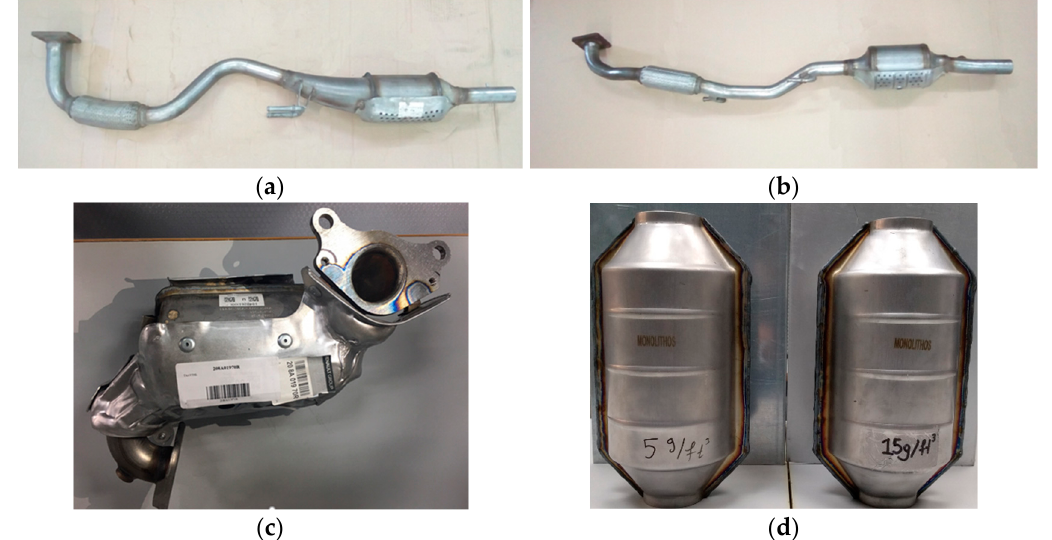
Figure 3. ( a ) OEM EURO III exhaust spare part for VW Polo 1.4 Lt; ( b ) OEM EURO IV exhaust spare part for VW Polo 1.4 Lt; ( c ) OEM EURO V/VI exhaust spare part for Renault Meganne 1.2 Lt Turbo; ( d ) PROMETHEUS Full Scale Monolithic Catalysts (5–15 g/ft 3 ).